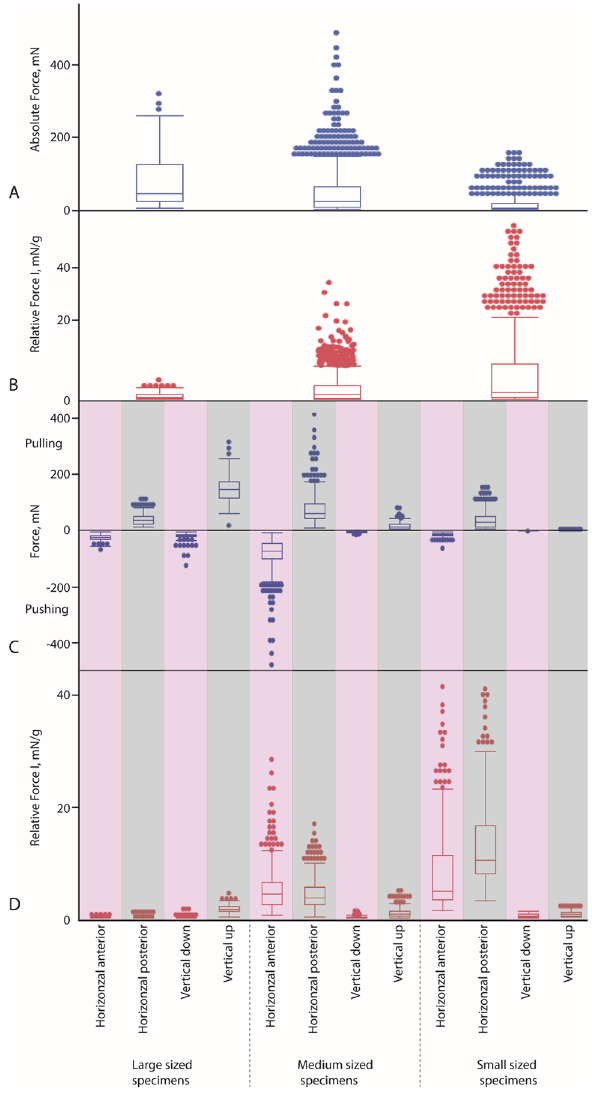
Figure 3. Absolute Force (blue boxplots) and Relative Force I (red boxplots) for distinct body mass classes (large-, medium-, and small-sized gastropods). ( A ) Absolute Force (regardless of the direction of measurement). ( B ) Relative Force I (regardless of the direction of measurement). ( C ) Absolute Force sorted to directions) ( D ) Relative Force I sorted to directions. Pink = pushing of radula, grey = pulling of